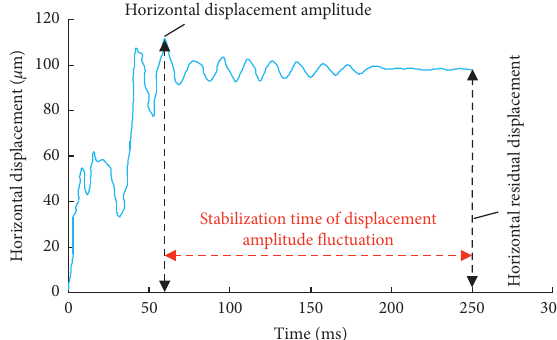
Figure 5: Horizontal displacement-time history curve of the working block under the vertical impact energy of